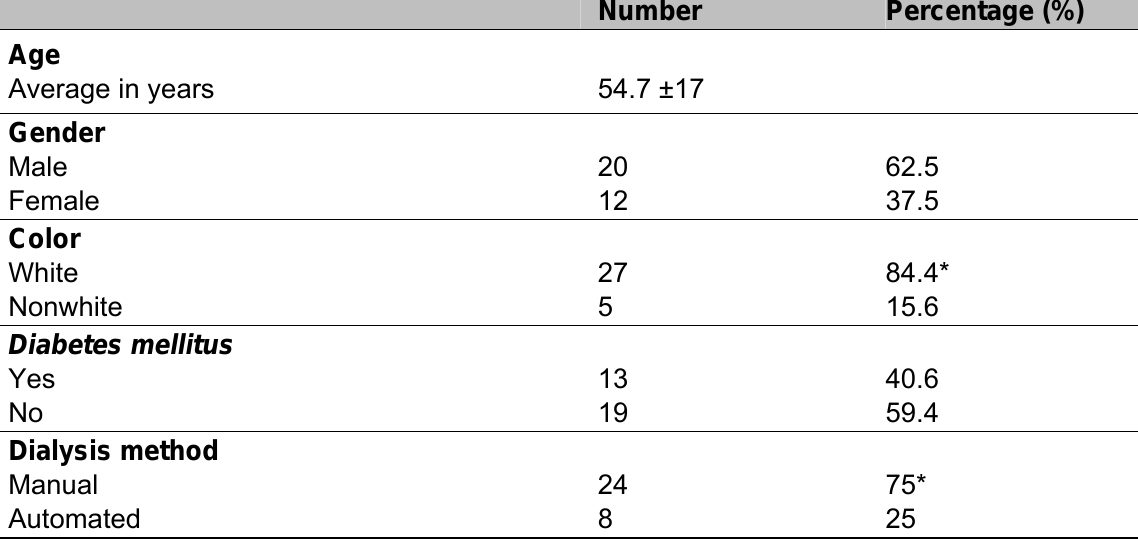
Table 1. Characteristics of the 32 patients subjected to peritoneal dialysis at home